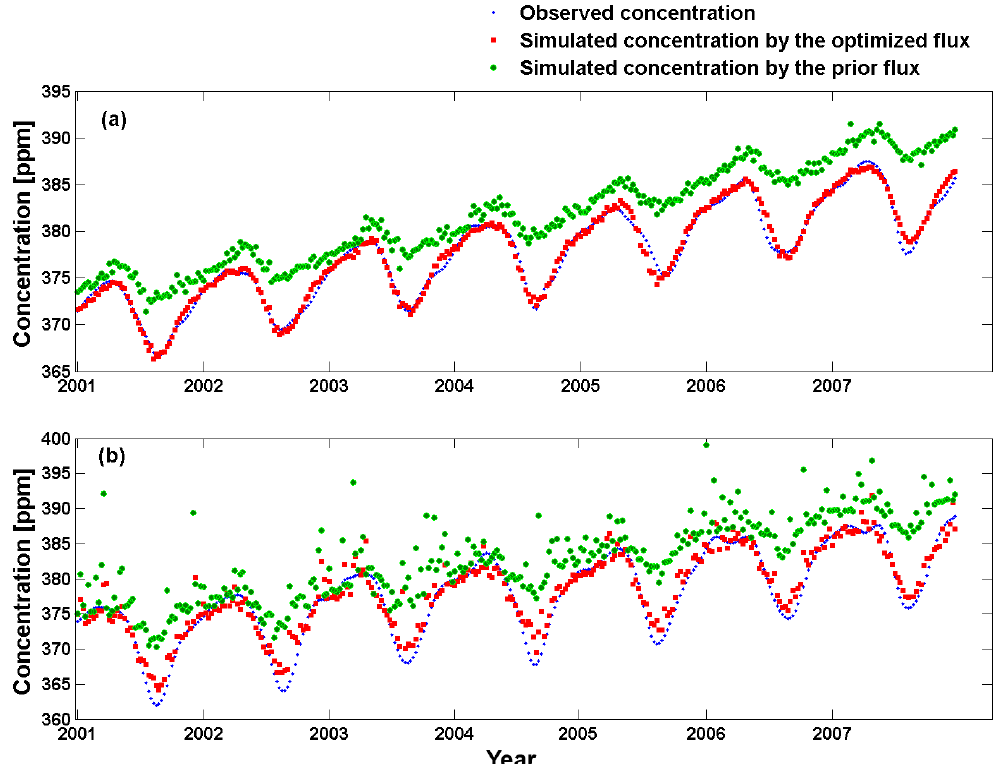
Figure 13. Observed (blue dots) concentration, simulated concentration with the optimized flux (red squares) and simulated concentration with the prior flux (green circles) from (a) Dahlen, North Dakota, United States (47.5 ◦ N, 99.24 ◦ W) (b) Mace Head, County Galway, Ireland (53.33 ◦ N, 9.9 ◦ W).